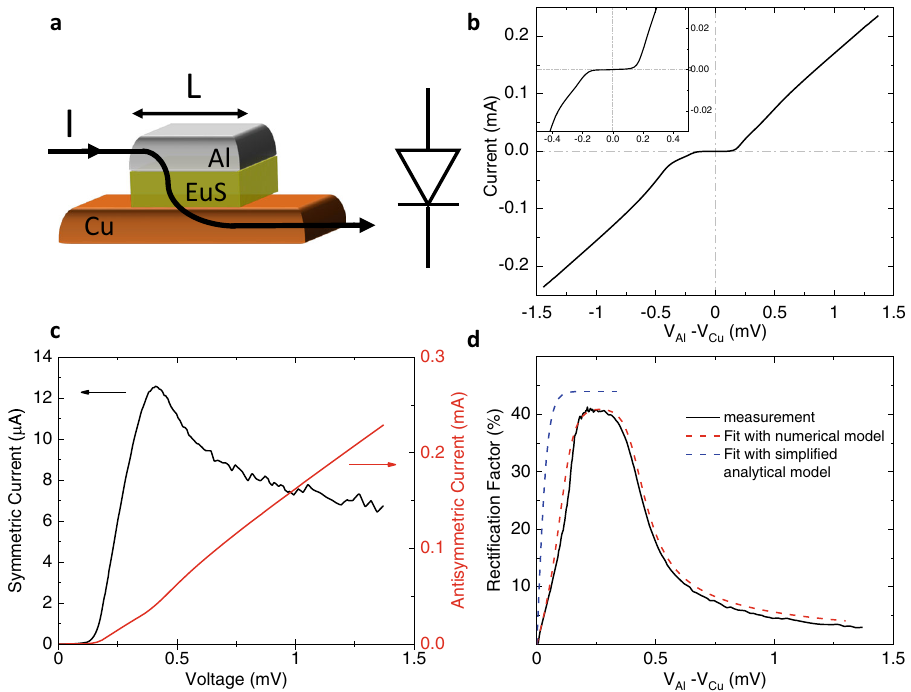
Fig. 2 Recti fi cation of the superconducting tunnel diode. a Schematic of the N/FI/S tunnel junction. The path of the tunneling current is indicated by the black line and its arrows. In terms of electronic circuit elements this junction behaves like the indicated diode: the current fl ows preferentially from the Al layer to the Cu layer while the reverse fl ow is inhibited. b Current-to-Voltage ( I ( V )) characteristics of the junction measured at T ≃ 50 mK, B = 0.1 T in the four-wire con fi guration (i). c Symmetric and antisymmetric parts of the I ( V ) characteristic of panel c showing a sizable symmetric component of the current. d Recti fi cation coef fi cient R ( V ) = I Sym ( V )/ I Antisym ( V ) evaluated from e (black line) along with the comparison with the recti fi cation extracted from the approximated analytical model R ¼ P tanh ½ eV = ð 2 K B T Þ(cid:3) (blue line) and the full numerical ones (red line). Details of the numerical model can be found in the Methods section, speci fi cally in Eqs. (3) and (14). Notice the good qualitative agreement with the simpli fi ed model predicting the saturation at R ≃ P ∼ 40% at 225 – 280 μ V. The model ceases to work when eV ≳ Δ − h ∼ 250 μ eV. The discrepancy between the analytical model and the experiment mostly comes from weak inelastic scattering, and to a lesser extent from spin relaxation and orbital depairing.